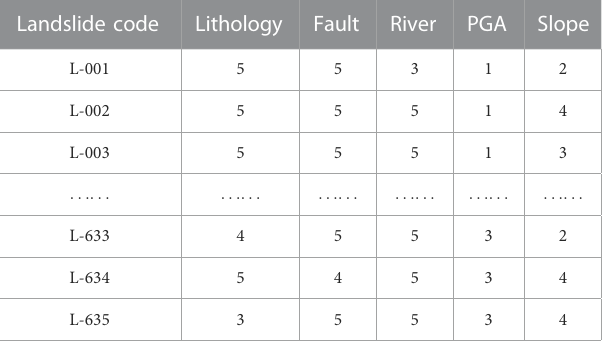
TABLE 3 Discriminant coef fi cient matrix of landslides in the study area. Landslide code